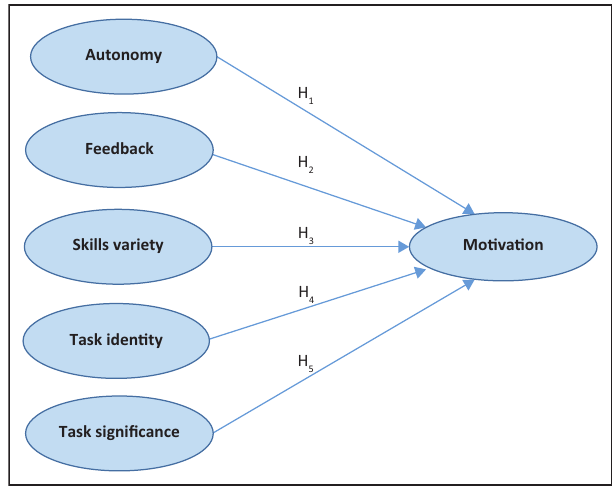
FIGURE 1 : Research